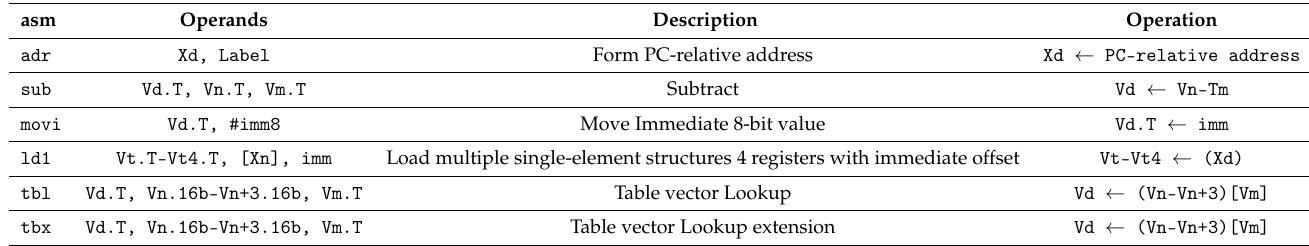
Table 2. Summary of instruction set for polynomial multiplication.